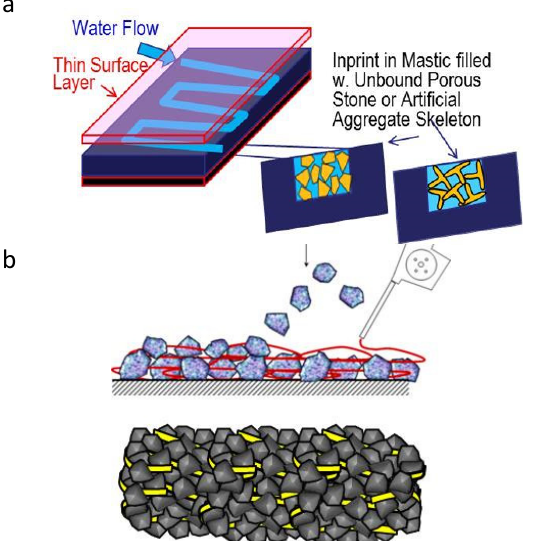
Figure 5. a) Principle of imprinted channels in mastic asphalt as replacement of pipes for energy harvesting; b) principle of